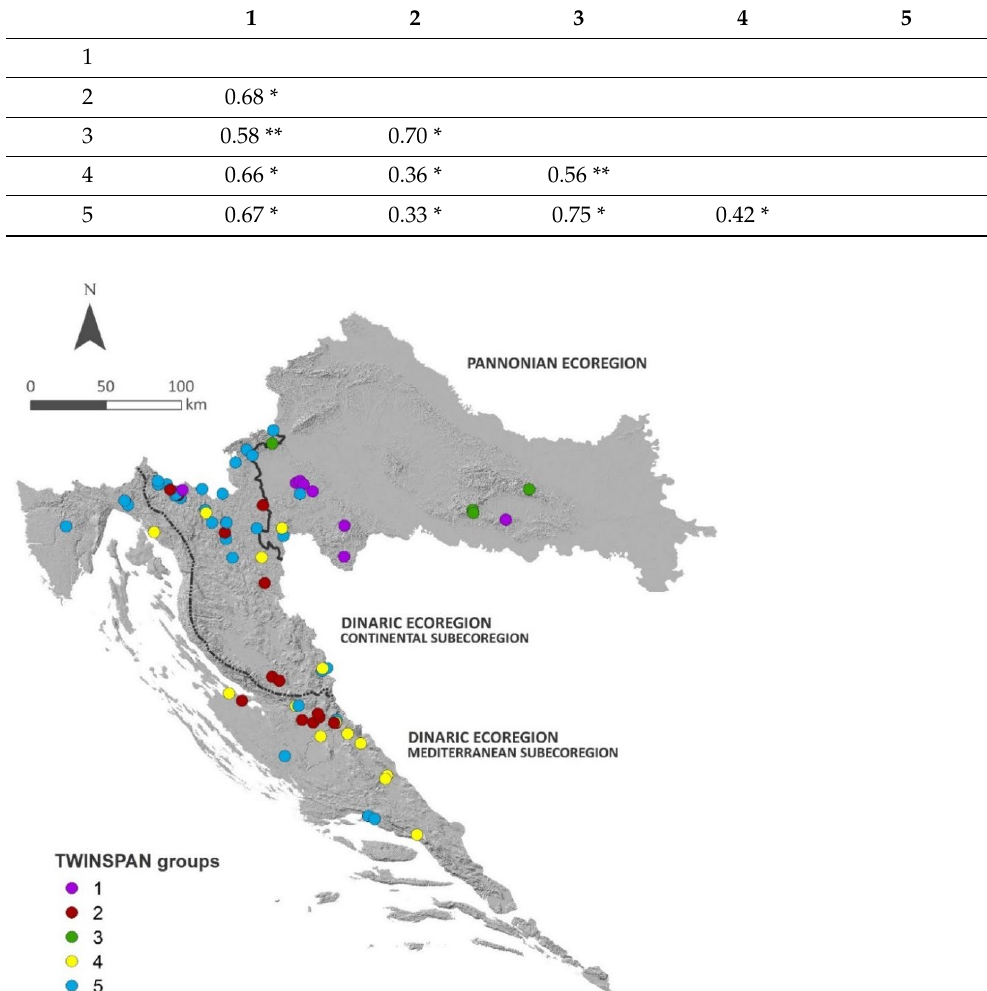
Table 1. R statistics of the pairwise ANOSIMs of bryophyte-dominated communities obtained from TWINSPAN classification (groups 1–5) (overall R = 0.50, p (same) = 0.0001), * p < 0.001, ** p < 0.005.